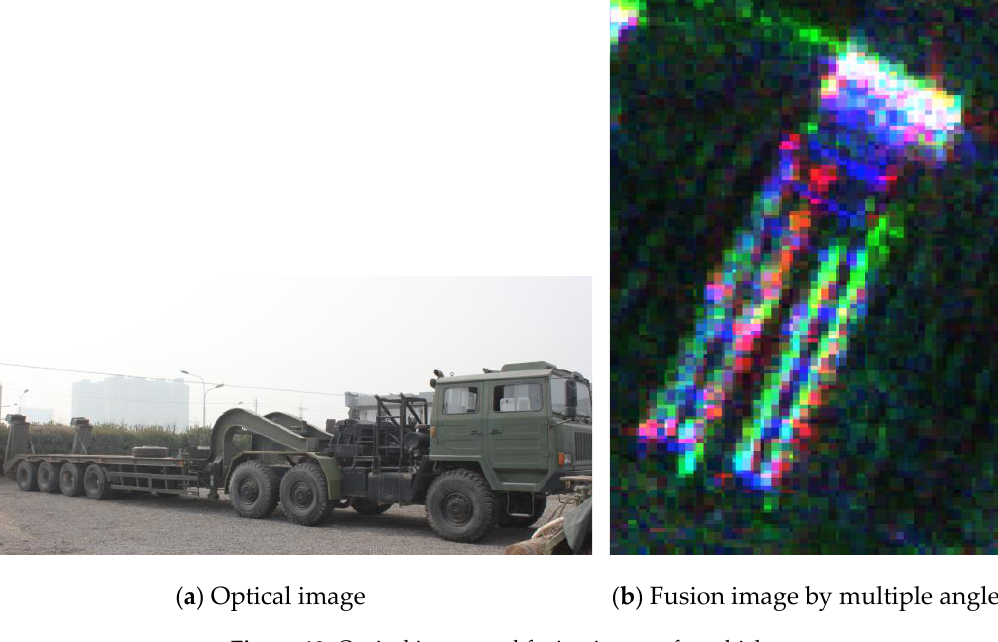
Figure 18. Optical image and fusion image of a vehicle.